Question: Give a one-sentence summary of this figure.
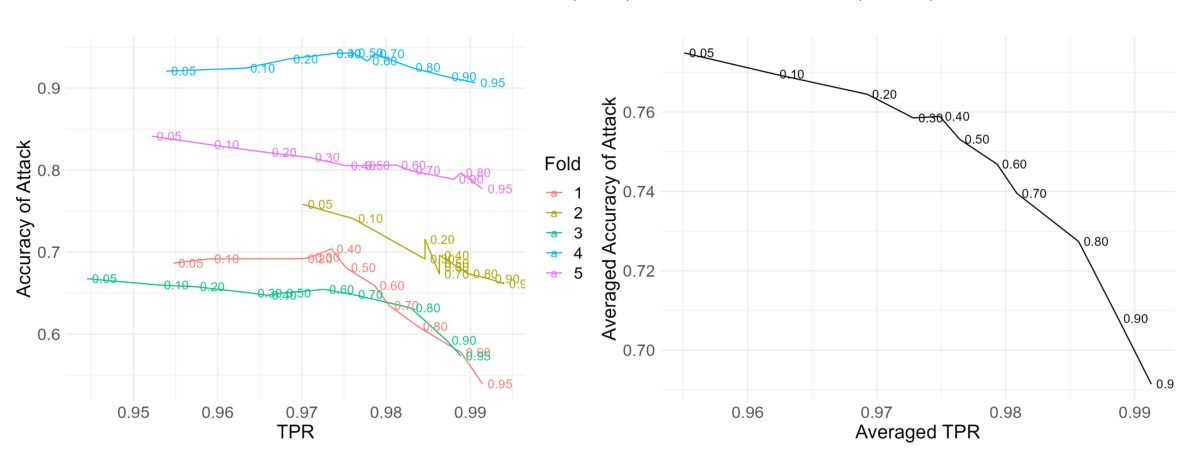
Answer: TPR versus Accuracy of Attack across Thresholds {0.05, 0.1, 0.2, . . . , 0.8, 0.9, 0.95} (la- beled next to the lines) for PD Plots of Age, COMPAS Data